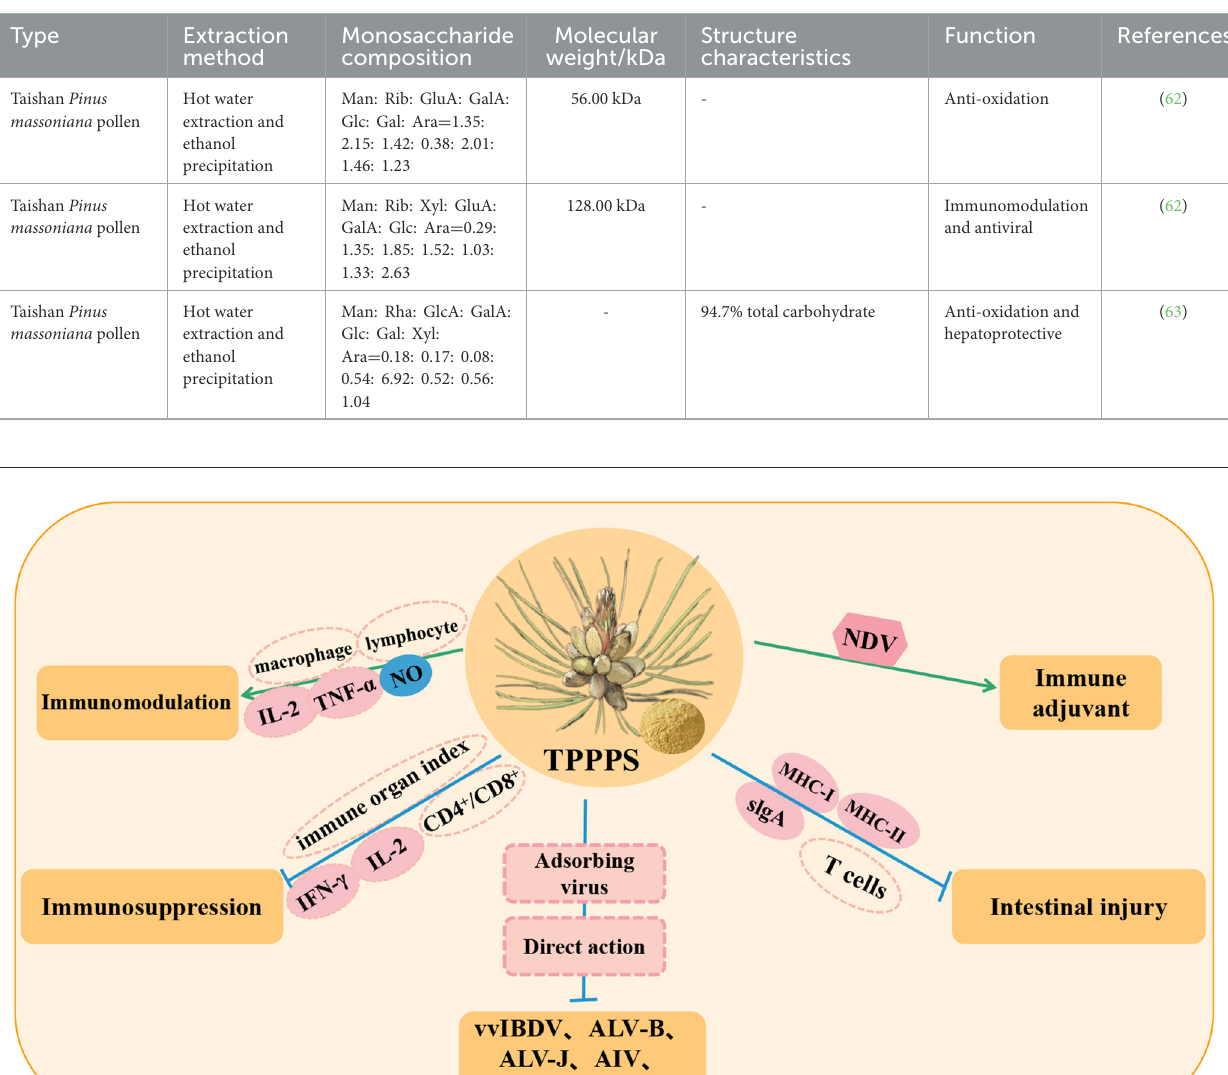
TABLE 3 Structure and structure-activity-relationship of polysaccharide from Taishan Pinus massoniana pollen.